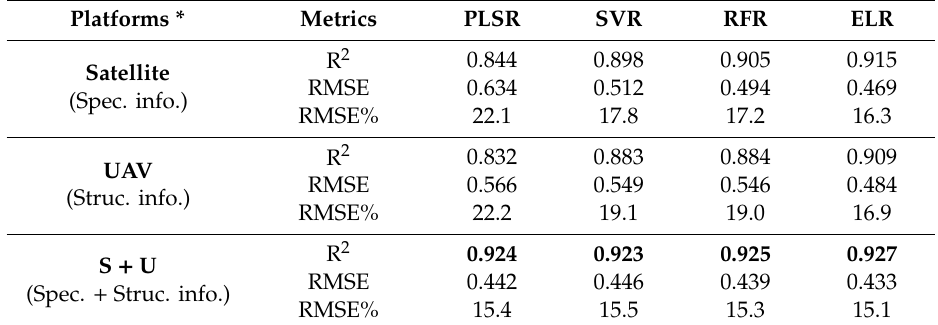
Table 5. Testing results of PLSR, SVR, RFR, and ELR methods for leaf area index (LAI) estimation.